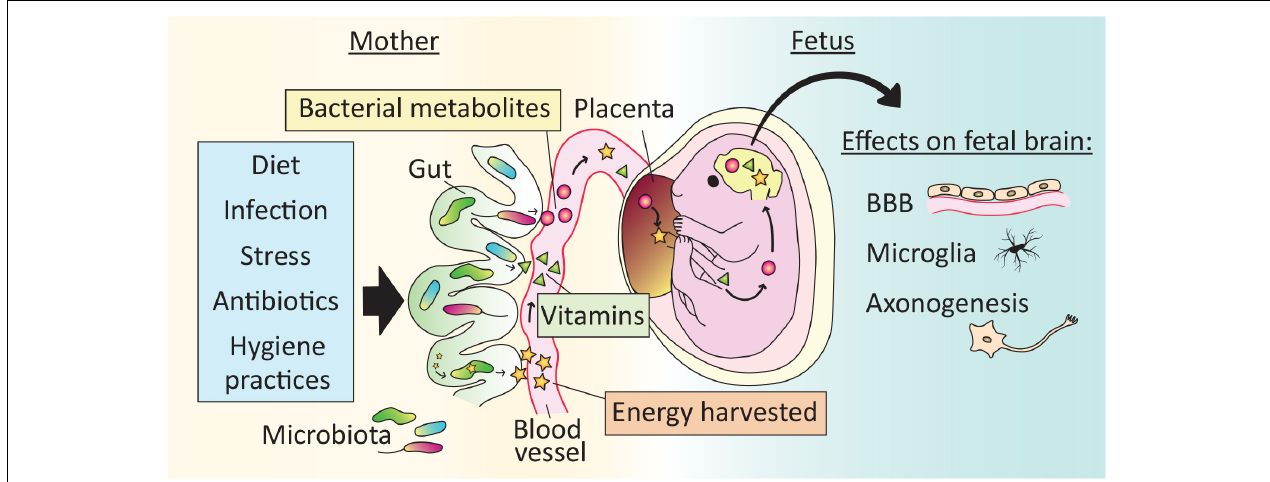
FIGURE 2 | Effects of the microbiota on brain development begin in utero . The maternal gut microbiota exerts effects on fetal brain development indirectly via the production of vitamins and bacterial metabolites, as well as by increasing the energy harvested from food. Microbe-dependent molecules cross the placenta and may reach the fetal brain. Reported effects of the maternal microbiota on fetal brain development include development of the blood brain barrier (BBB), microglial cell number and physiology, and axonogenesis. As a result, perturbations to the maternal microbiota, for example via lifestyle (e.g., diet), illness (e.g., stress or infection) or medical treatment (e.g., antibiotics), may affect offspring brain